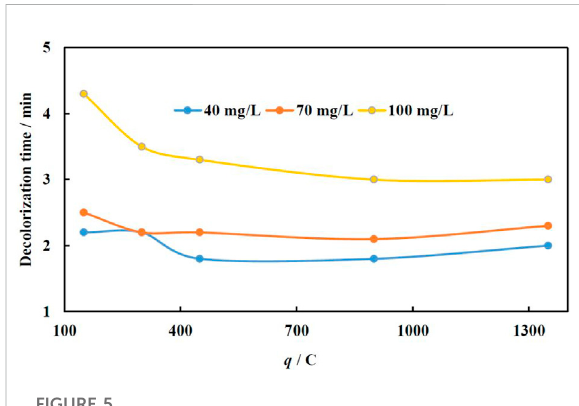
FIGURE 5 Dependence of decolorization time on MO concentration and catalyst deposition conditions (charge passed), at 40 ° C, 90 µL